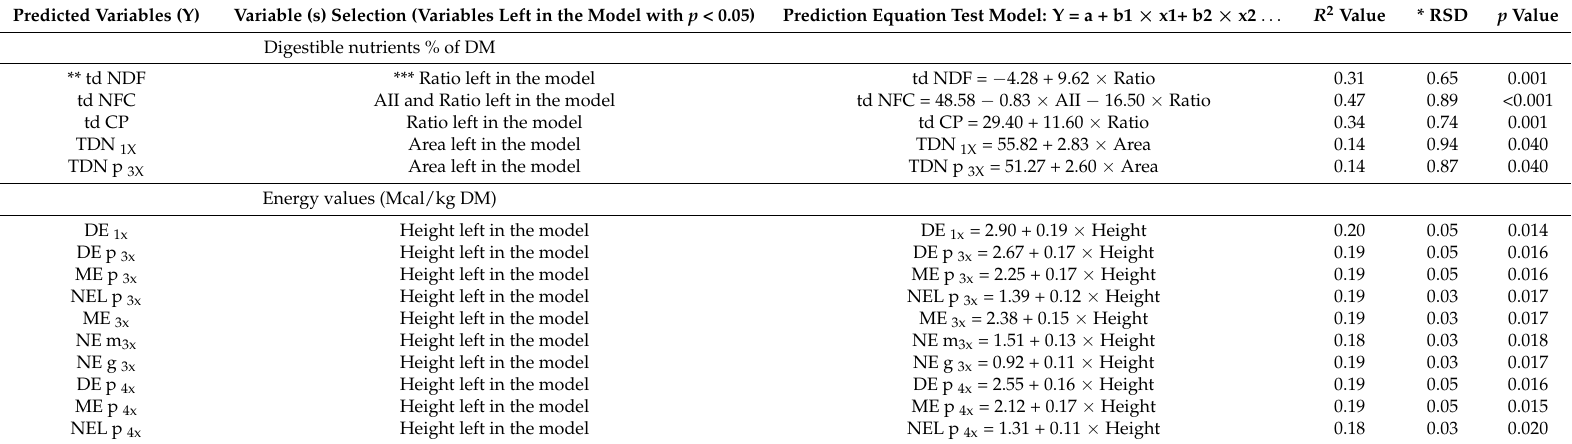
Table 14. Multiple regression analyses to find the important protein structural variables for predicting energy values of canola meal Predicted Variables